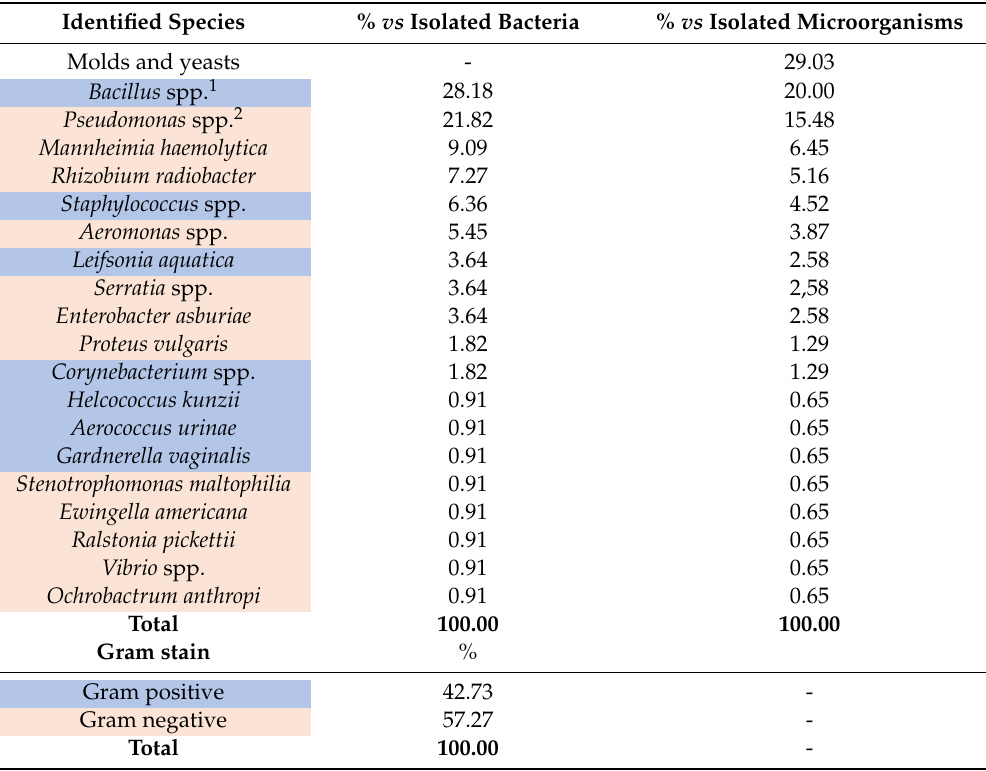
1 Blue indicates that the bacteria are Gram-positive. 2 Orange indicates that the bacteria are Gram-negative.